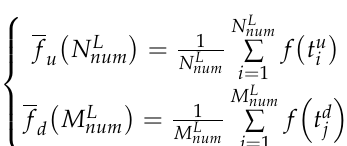
(cid:0) (cid:1) (cid:0) (cid:1) N L M L and f , which are calculated num num u d